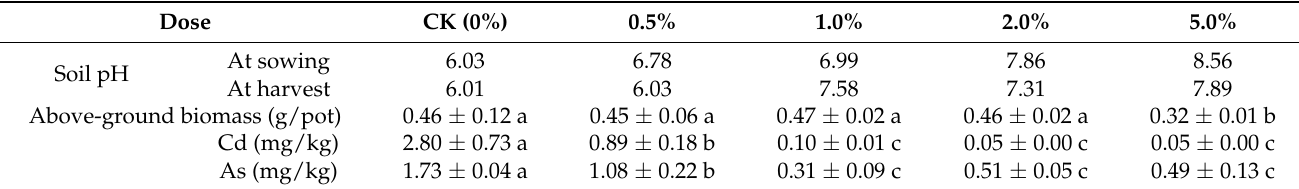
Table 2. Ca-humic complex affects the above-ground biomass and Cd and As contents of the vegetable bok choy.